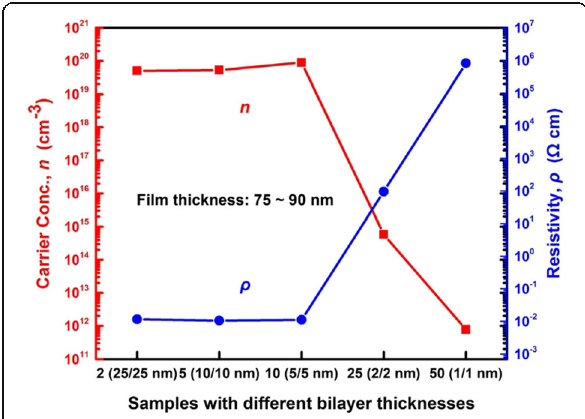
Fig. 9 Carrier concentration and resistivity of nanolaminates grown on quartz substrate with different bilayer